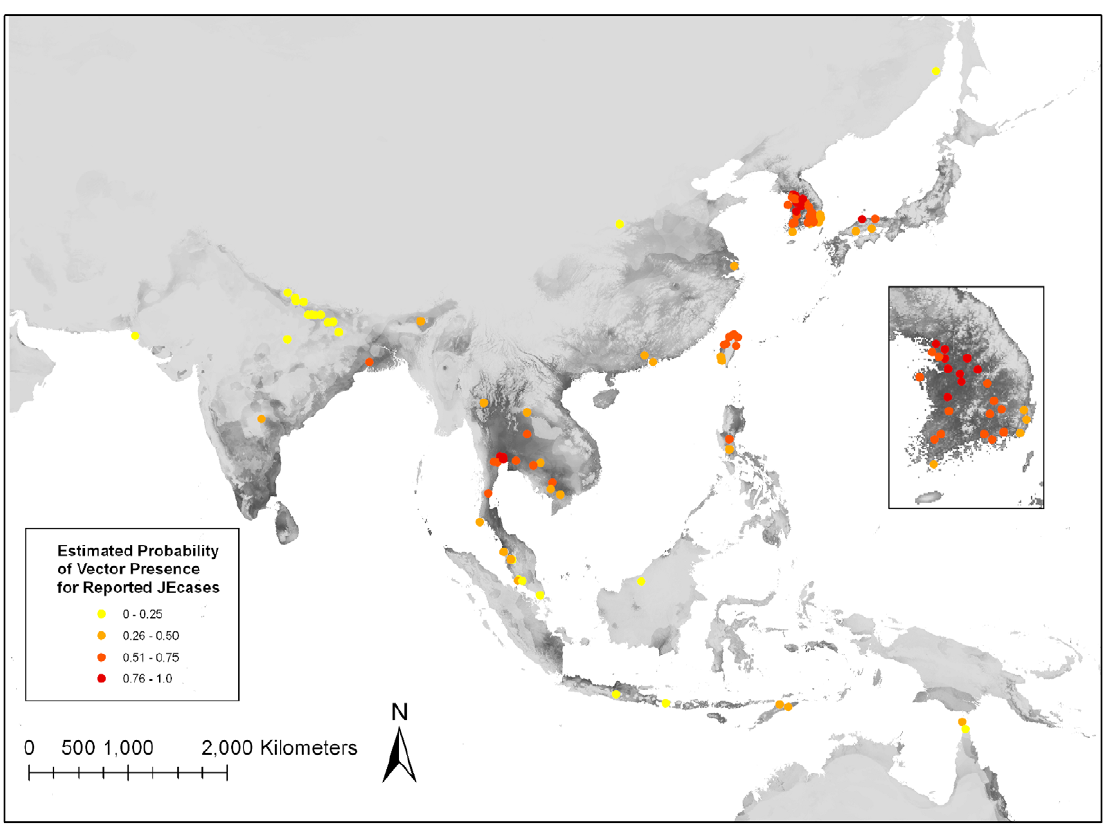
Figure 4. Human JE cases categorized by color based on the estimated probability of Cx.tritaeniorhynchus presence. tritaeniorhynchus (Figure 4). Regions of estimated high probability of Cx. tritaeniorhynchus presence (Figure 3) are representative of